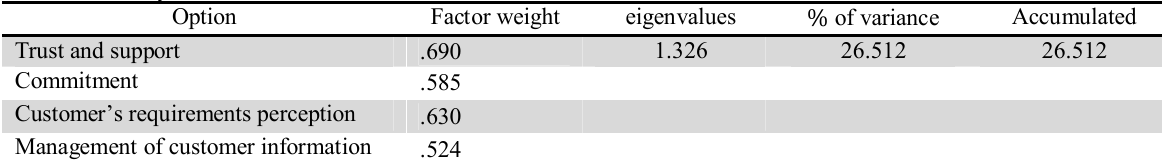
The summary of factors associated with customer retention